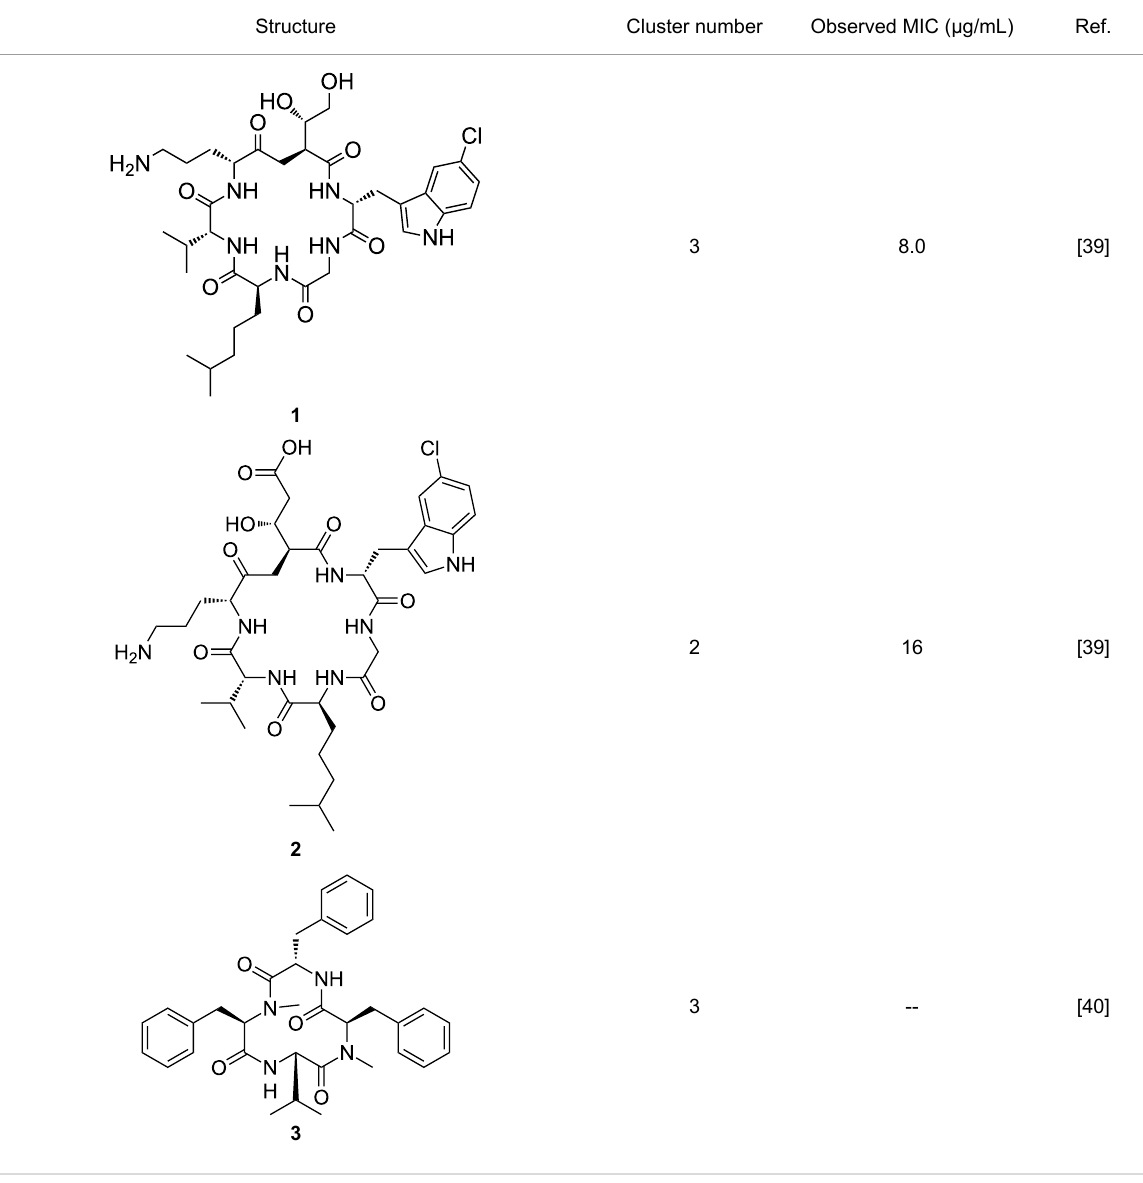
Table 1: Structures of cyclic peptides with their MIC